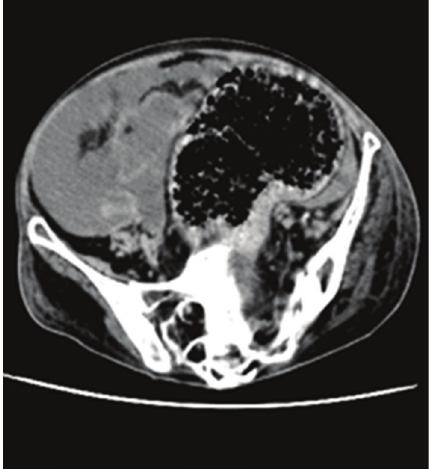
Figure 3: Distended sigmoid